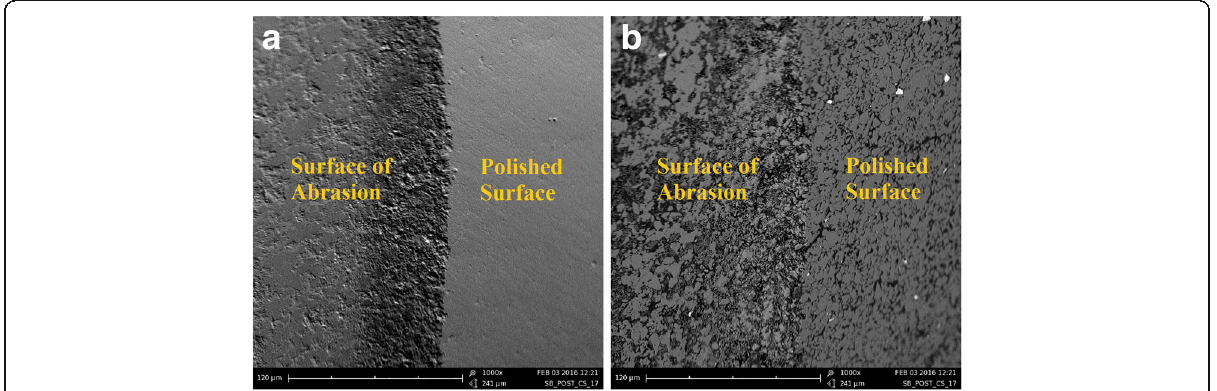
Fig. 5 SEM images of the mesial margin of abrasion under topography contrast ( a ) and material contrast ( b